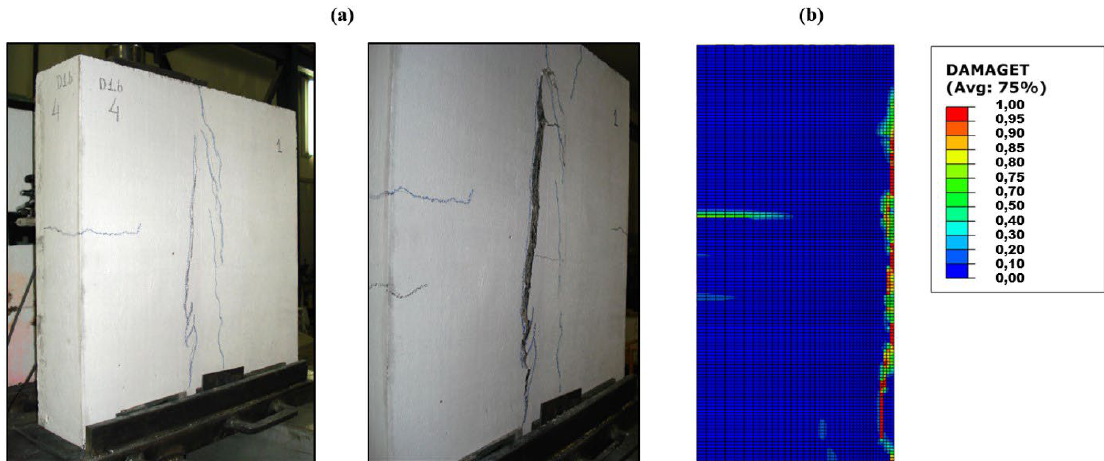
Figure 14. Concrete slab cracking: (a) experiment and (b) numerical model (group D1).